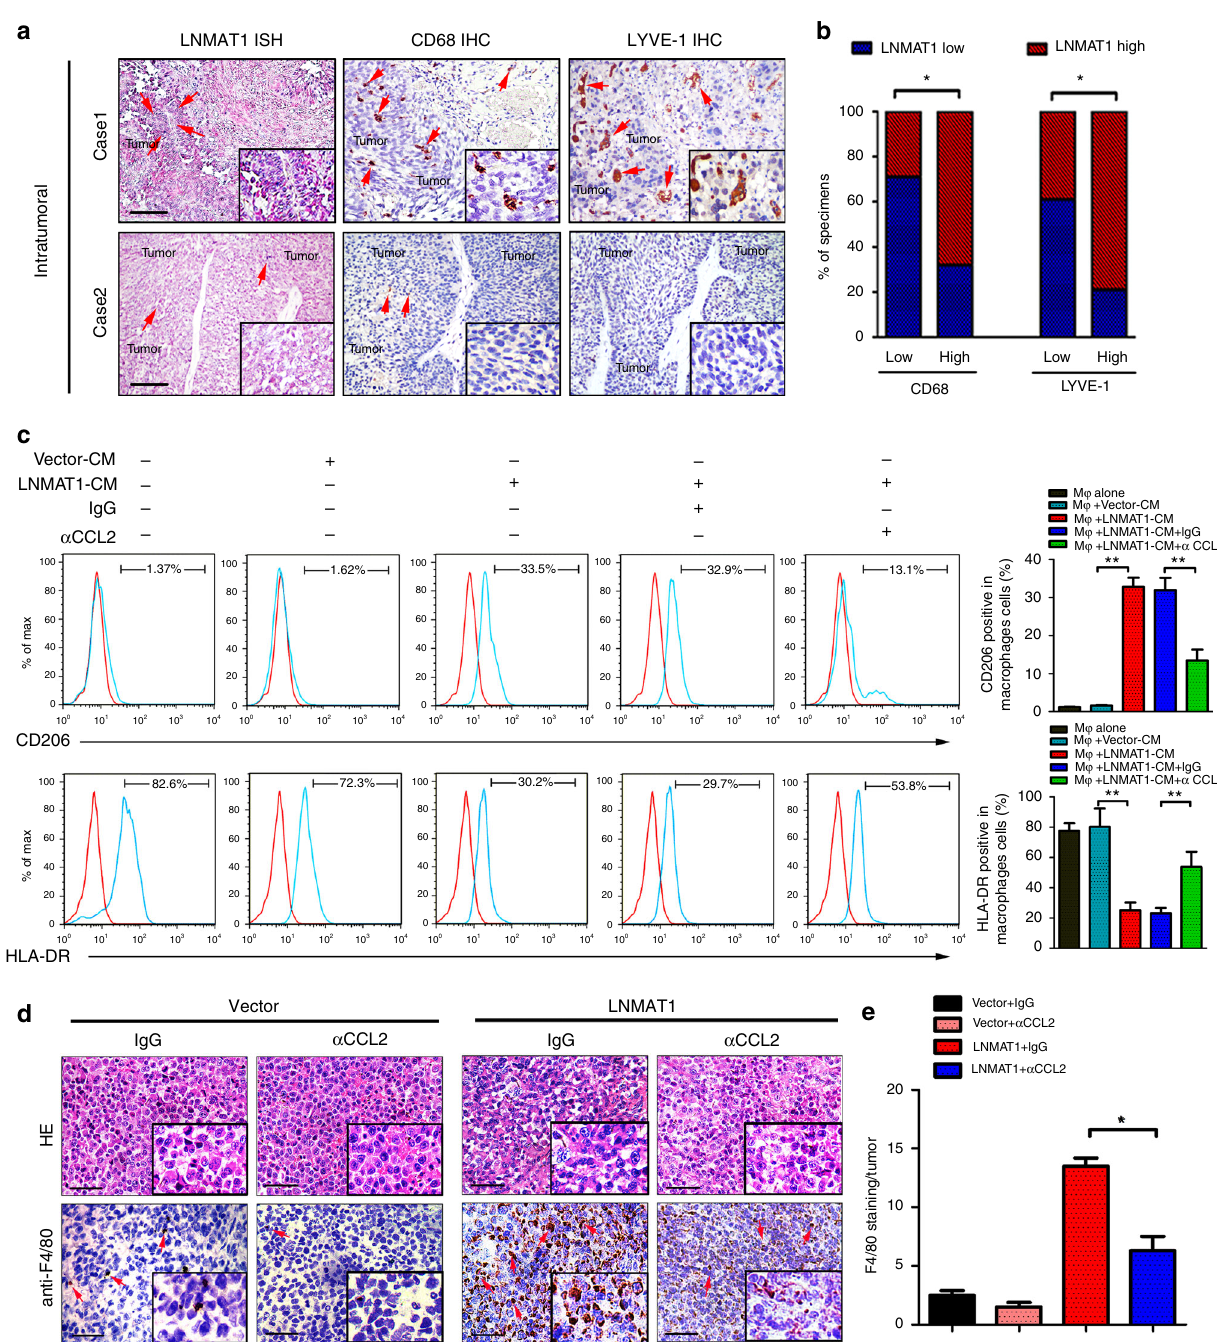
Fig. 7 LNMAT1 -upregulated CCL2 activates TAMs. a , b Representative images and percentages of bladder cancer tissues with high or low levels of CD68- positive cells and LYVE-1-positive cells in the intratumoral tissues with different LNMAT1 expression levels. LNMAT1 expression levels were quanti fi ed by ISH, macrophage density was quanti fi ed by IHC using anti-CD68 antibody and microlymphatic vessel density was quanti fi ed by IHC using the anti-LYVE-1 antibody. Two representative cases are shown. Statistical signi fi cance was assessed by χ 2 test. Scale bars: 100 μ m. c Flow cytometric analysis and quanti fi cation of the expressions of CD206/HLA-DR in macrophages treated with medium collected from the indicated cells for 24 h. CCL2-neutralizing treatment was carried out for an additional 18 h. Statistical signi fi cance was assessed by two-tailed t -tests. d , e Representative images ( d ) IHC staining evaluating macrophages with anti-F4/80 as indicating with red arrows and histogram analysis ( e ) in primary tumor from the footpads of nude mice. Scale bars: 100 μ m. Statistical signi fi cance was assessed by two-tailed t -tests. The error bars represent standard deviations of three independent experiments. * p < 0.05, and ** p <